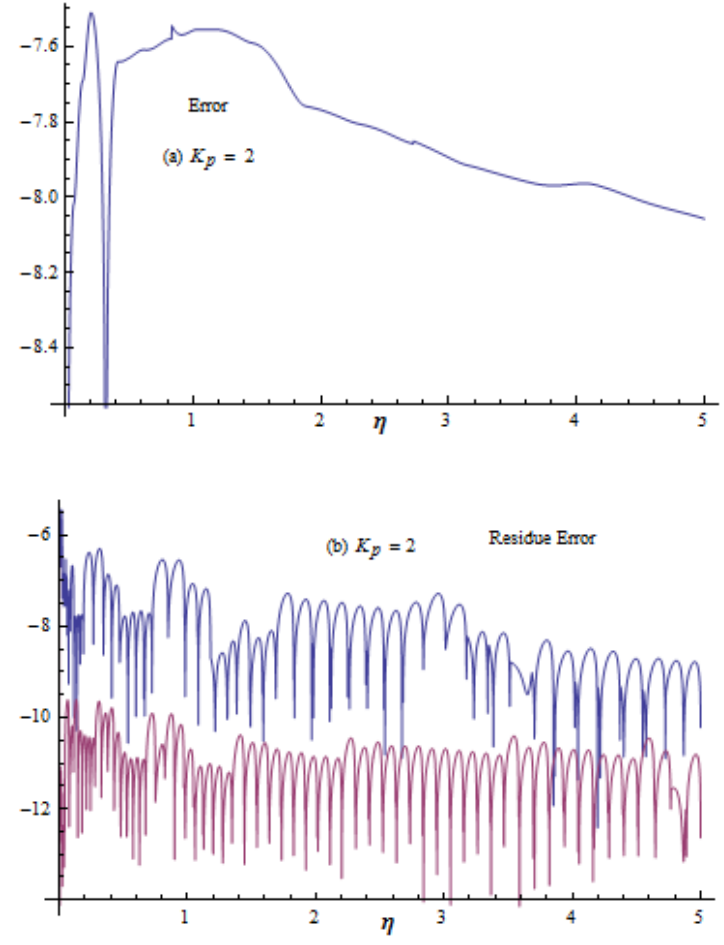
Figure 2. Error ( a ) and residue error ( b ) for K p = 2. The blue line represents the average residue error and the red line represent the total average residue error in ( b ).